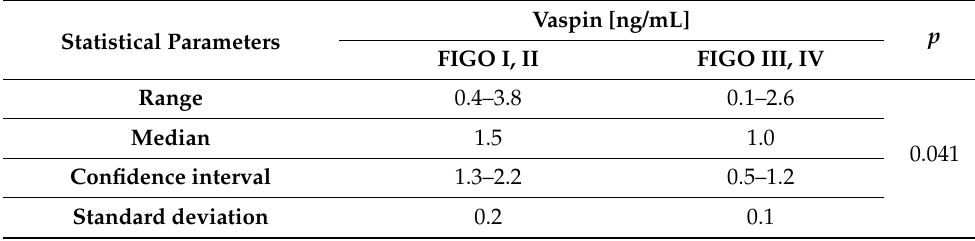
Table 6. Evaluation of serum vaspin levels in patients with endometrial cancer in relation to sub- groups: G1–3, grading 1–3; FIGO, International Federation of Gynecology and Obstetrics; LVSI metastases, lymphovascular space invasion